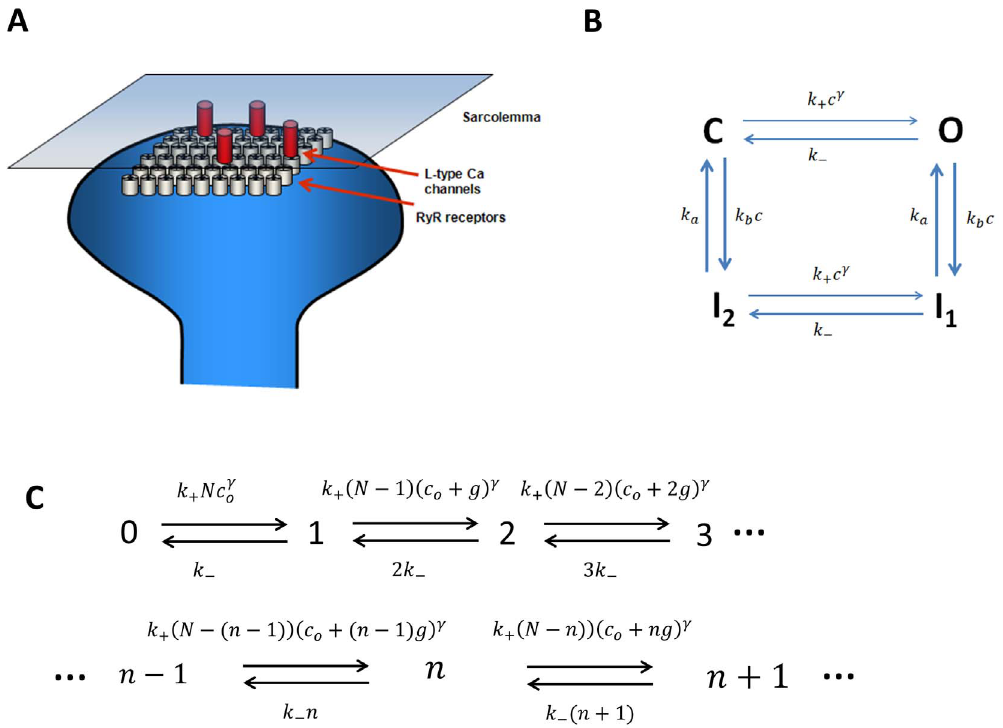
Figure 1. (A) Schematic illustration of the calcium release unit (CRU) showing a cluster of RyR channels on the SR in the vicinity of a few LCC channels on the membrane. (B) Four state Markovian scheme describing the RyR channel. (C) Birth-death process describing the closed to open transitions of N RyR channels in the cluster.